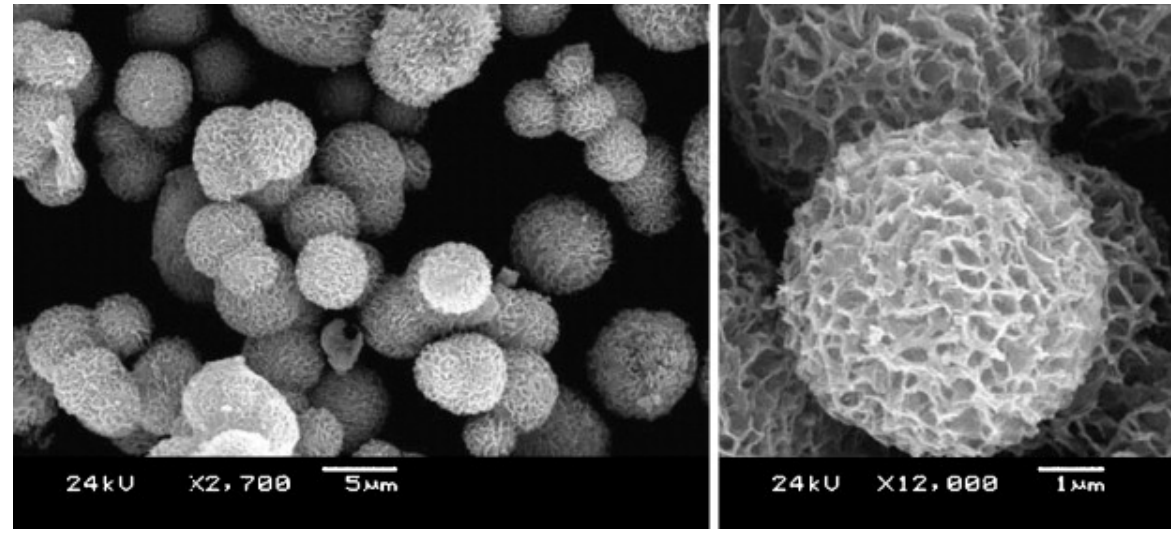
Figure 8. SEM images of as-prepared porous nanosheet-based ZnO microsphere with low (left) and high magnification (right)